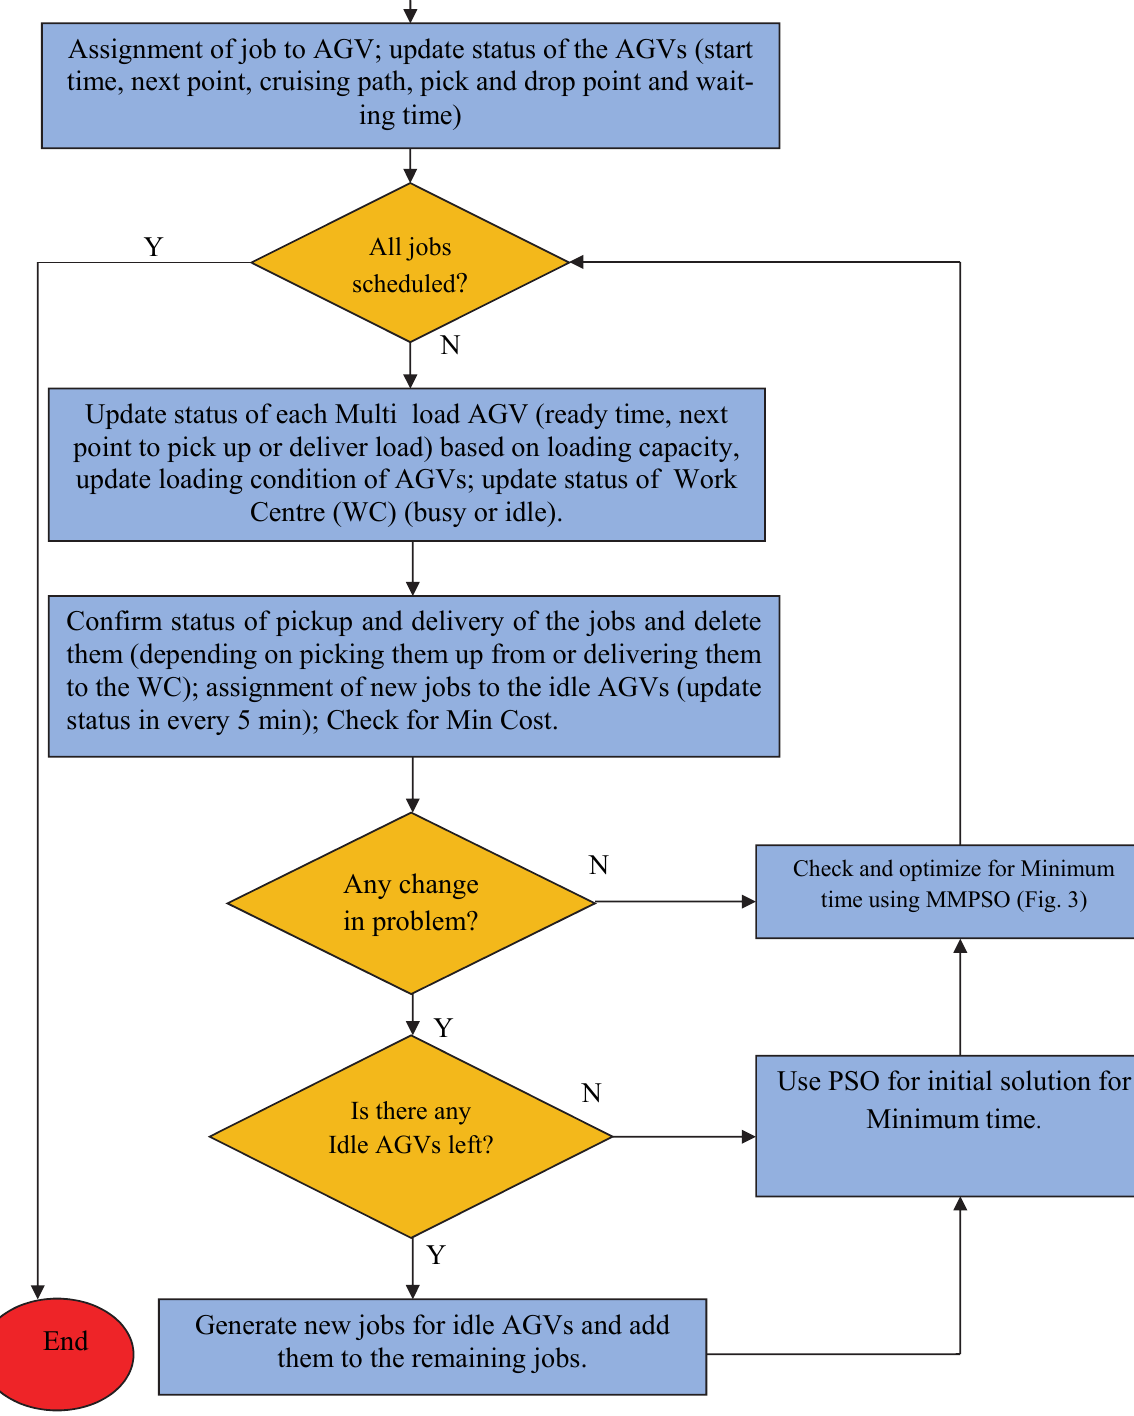
Fig. 2. Flow Chart for the